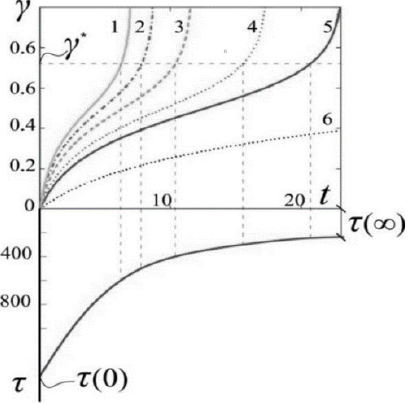
Figure 4. Creep curves γ –t at τ 1 > τ 2 > · · · τ 5 (the top part) and the long-term strength curve (the bottom part) τ (0) → τ ( ∞ ) at t → ∞ , obtained using Formula (3).